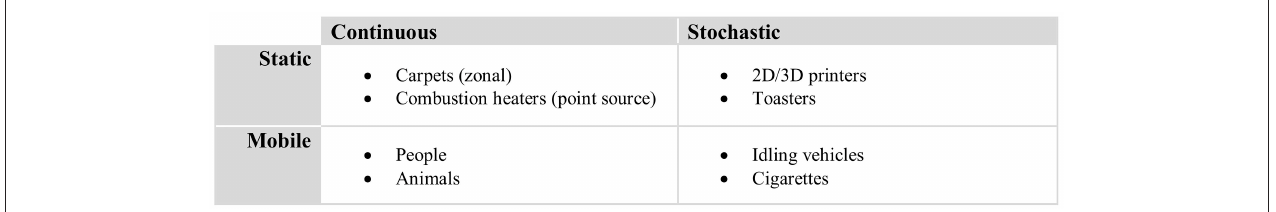
FIGURE 1 | Pertinent to the sensing of indoor air quality is whether a particular source pollutes continuously or stochastically, and whether a source is mobile or static. Common sources of indoor air pollution are categorized as